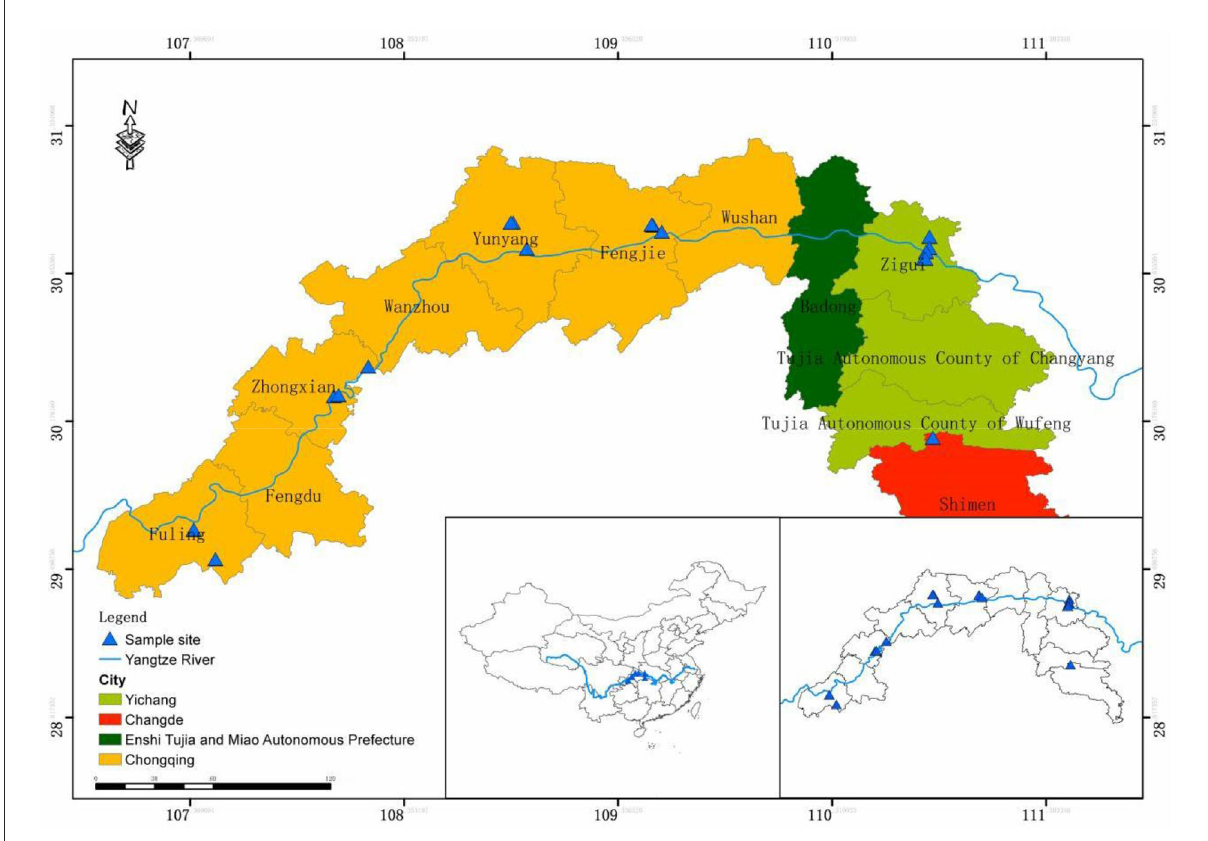
FIGURE1 Sample point distribution